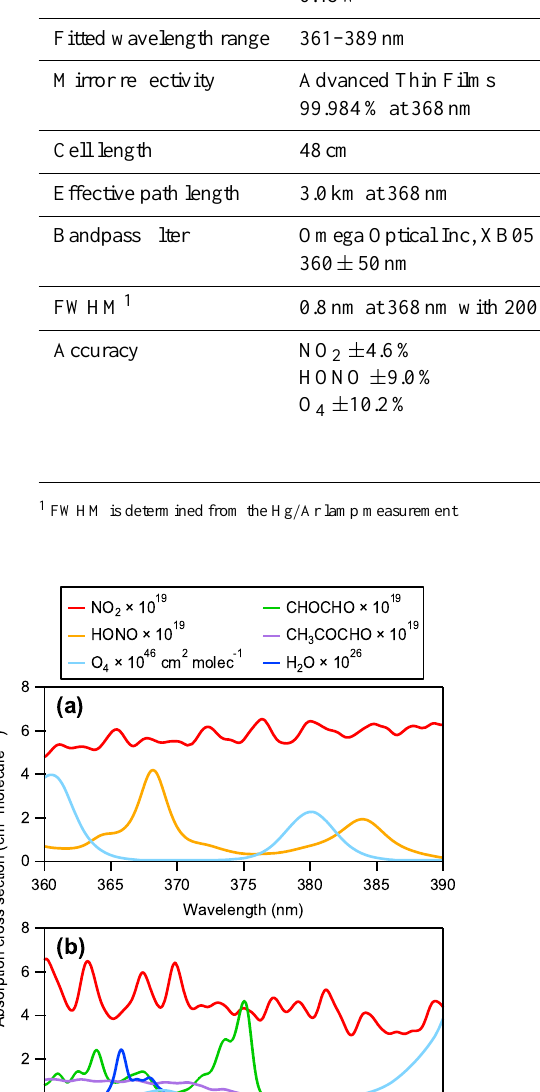
CA, USA) are separately temperature-controlled using ther- moelectric coolers. Their output light is collimated using off-axis parabolic mirrors (50328AL, 2.0 cm effective focal length, Newport Corp., Irvine, CA, USA) prior to